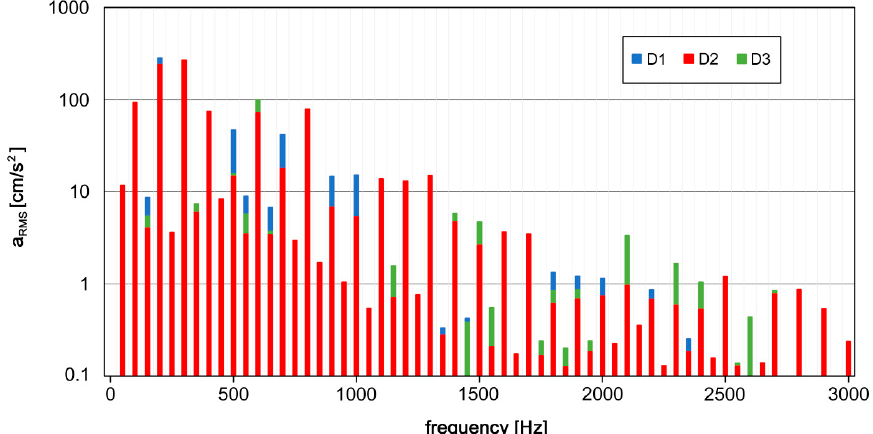
Figure 4. Comparison of the values of the dominant components of the frequency spectrum of transformer No. 4 (25 MVA) in the range from 0 Hz to 3 kHz for different sensor locations (according to Figure 3a).